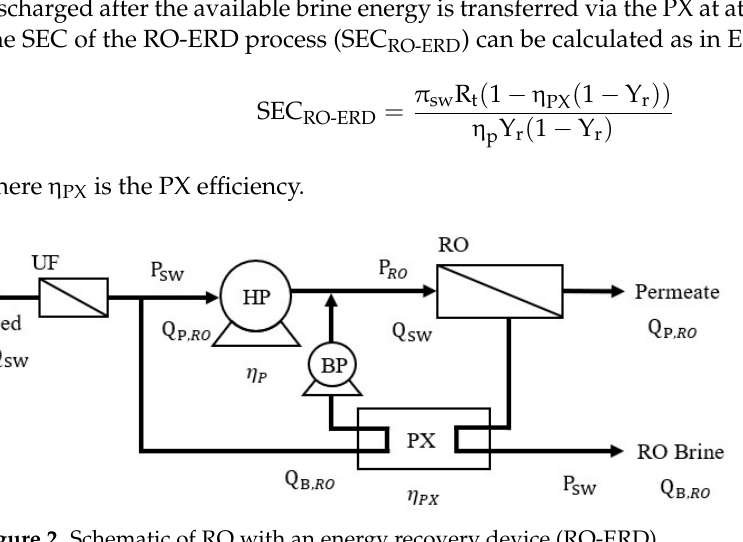
Figure 2. Schematic of RO with an energy recovery device (RO-ERD).